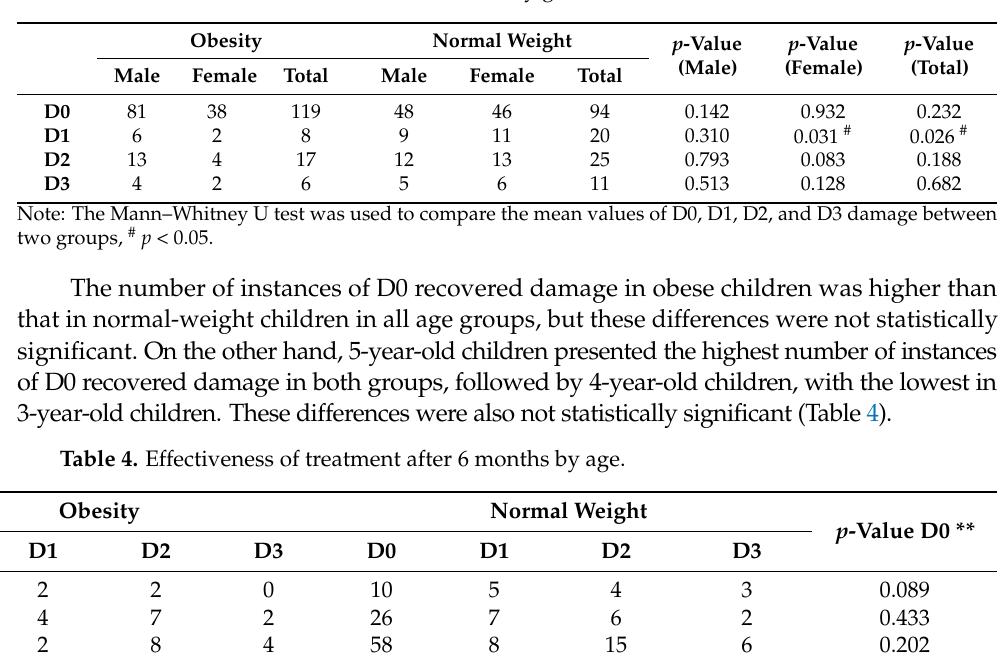
Table 3. Effectiveness of treatment after 6 months by gender.